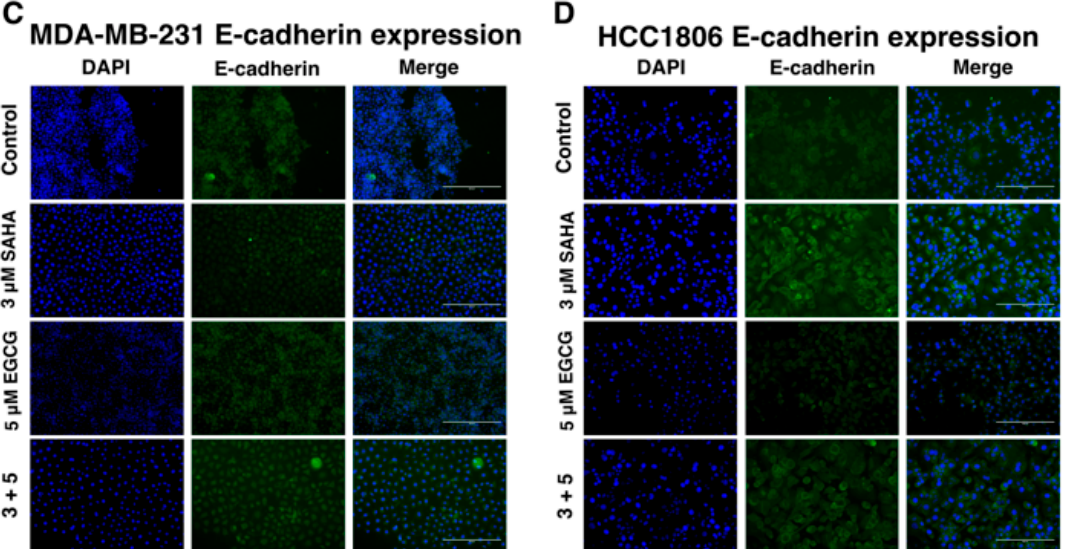
Figure 14. E-cadherin expression is increased on the cell surface with the combination treatment of SAHA and EGCG. ( A ) MCF-7 cells were treated for 72 h with the indicated compounds then fixed with 4% formaldehyde and blocked with 10% fetal calf serum. Anti-E-cadherin antibody (Cell Signaling Technology, Danvers, MA, USA) was applied at a 1:100 dilution overnight then washed with PBST. Fluorescently tagged secondary antibody (Abcam) was applied at a 1:1000 dilution for 30 min before adding mounting media (Thermo Fisher, Waltham, MA, USA) and letting it dry overnight. ( B – D ) The same was done in MDA-MB-157, MDA-MB-231, and HCC1806 TNBC cells. Cells were imaged on an EVOS microscope at 20 × ( n =